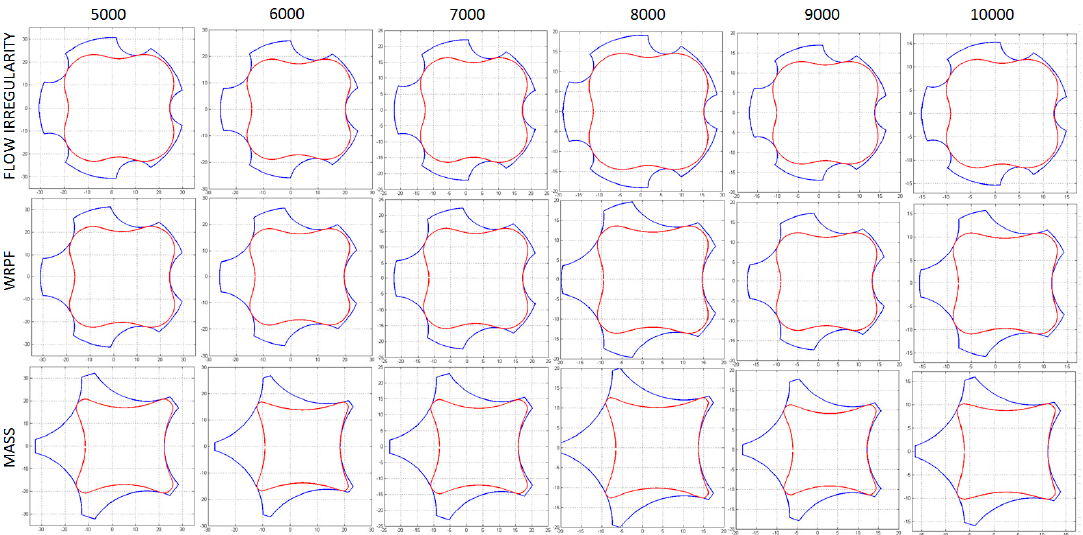
Figure 15. Optimized cycloidal profiles in the 5000–10,000 rpm range.